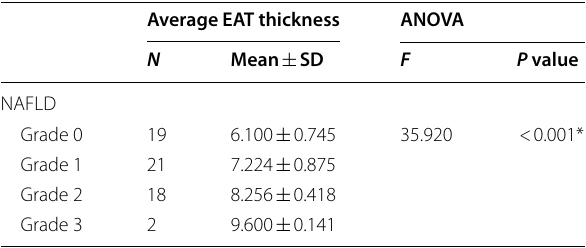
Table 9 Correlation between average EAT thickness and grading of NAFLD among the study population